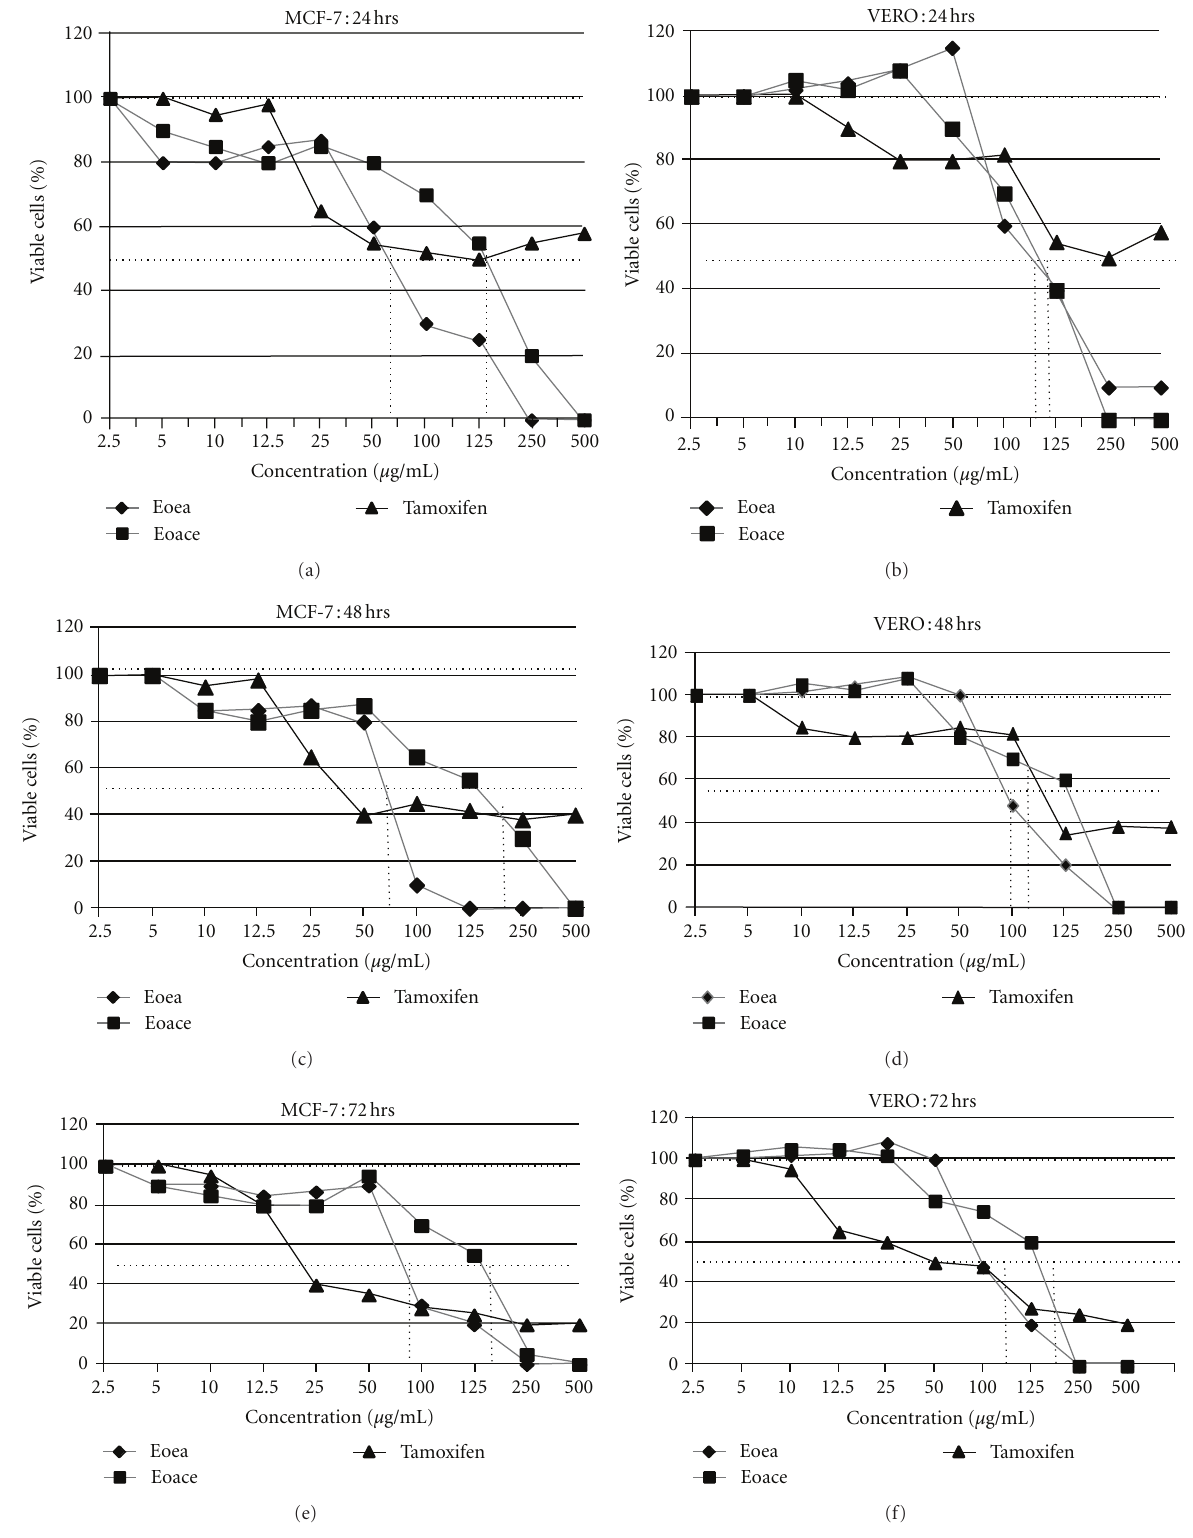
Figure 1: Graph showing cell death induced by acetone and ethyl acetate extracts of E. odoratum on MCF-7 and Vero cell culture in vitro at various time periods: 24 hours, 48 hours, and 72